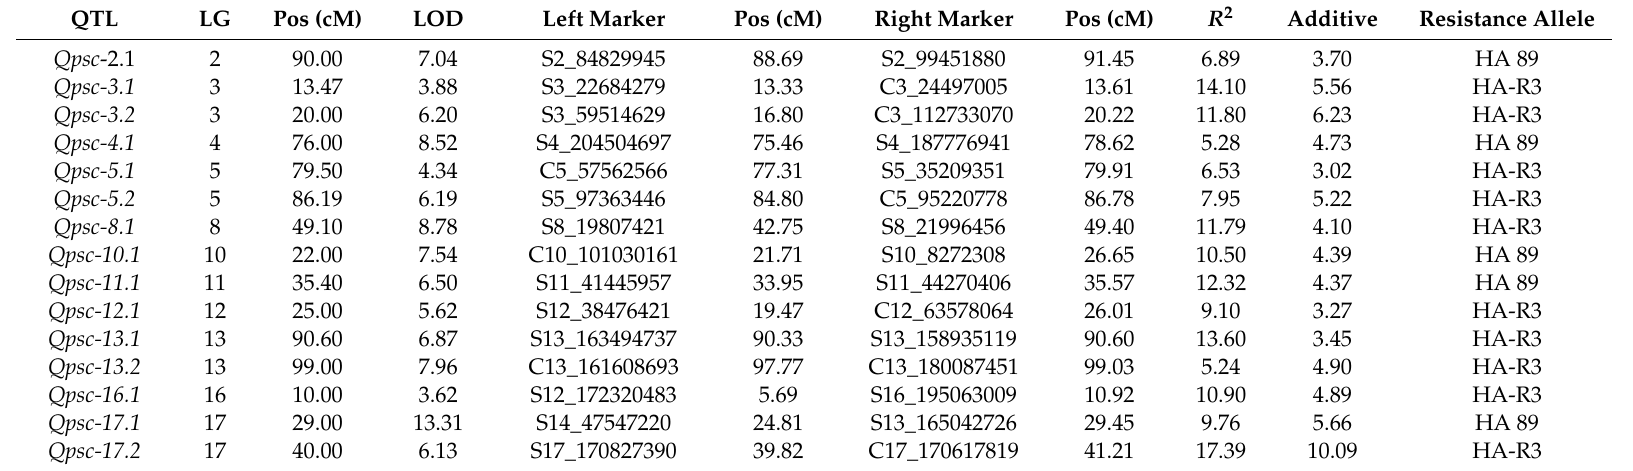
Table 4. Quantitative trait loci for Phomopsis stem canker resistance identified in combined analysis using best linear unbiased predictor (BLUP) of integrated disease incidence data collected from the HA 89 / HA-R3 recombinant inbred line population across seven environments during 2016 to